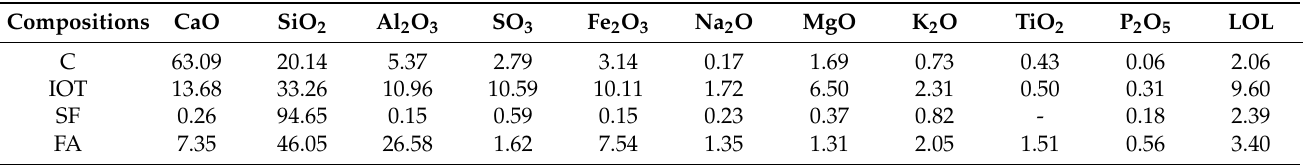
Figure 2. X-ray diffraction analysis of iron ore tailing. Table 1. Chemical compositions of used cementitious materials